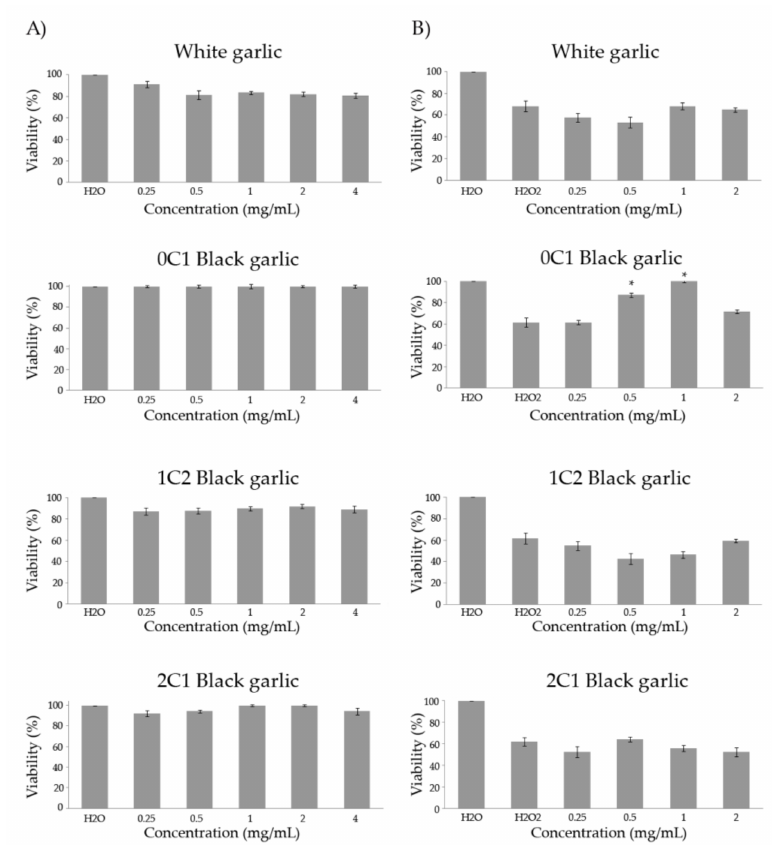
Figure 1. Toxicity ( A ) and antitoxicity ( B ) levels of black and white garlic studied in D. melanogaster . ( A ) Percentage of viability of Drosophila treated with di ff erent concentrations of the assayed garlic. ( B ) Viability of Drosophila tested with di ff erent concentrations of the tested garlic combined with the genotoxicant hydrogen peroxide at 0.12 M. Values represent the mean ± SE from three independent experiments. *: significant ( p ≤ 0.05), with respect to their concurrent controls. 0C1: black garlic with 13 days aging, 1C2: black garlic with 32 days aging, and 2C1: black garlic with 45 days